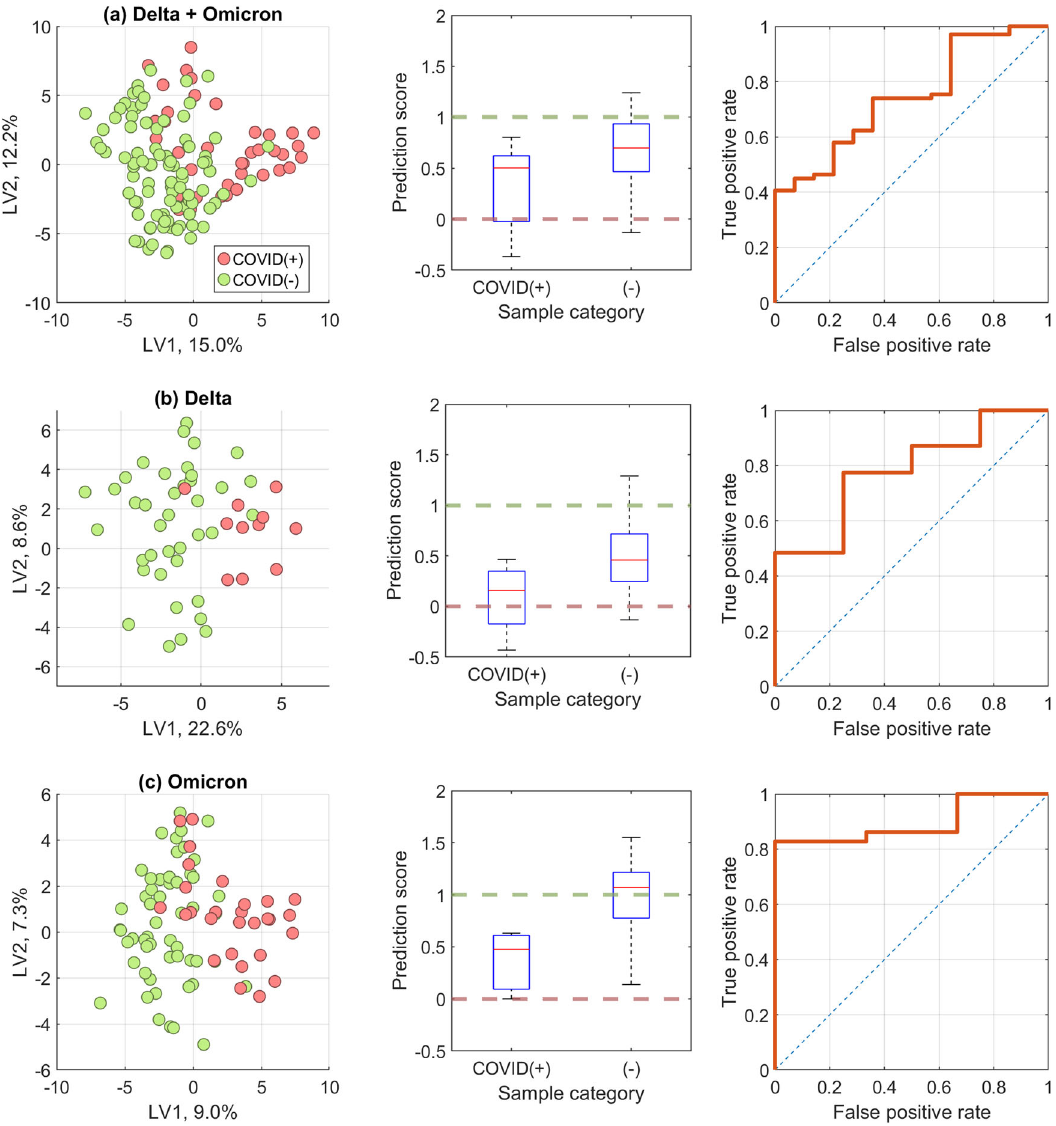
Fig. 1 Comparisons of breath-based models calibrated with and without regard to COVID variant. Partial least squares-discriminant analysis (PLS-DA) model comparisons when models were developed using a breath samples collected during the wave of both variants, b just the Delta wave, and c just the Omicron wave. Data show scatter plots of latent variable (LV) scores; boxplots of PLS-DA prediction scores from breath samples with 1 modeled as COVID( − ) and 0 as COVID( + ); and receiver operator characteristics (ROC) curves showing model accuracies to predict COVID infection from breath volatile organic compounds (VOCs). Analyses were conducted from breath samples of n = 96 COVID( − ), n = 12 Delta COVID( + ), n = 28 Omicron COVID( + ) persons.